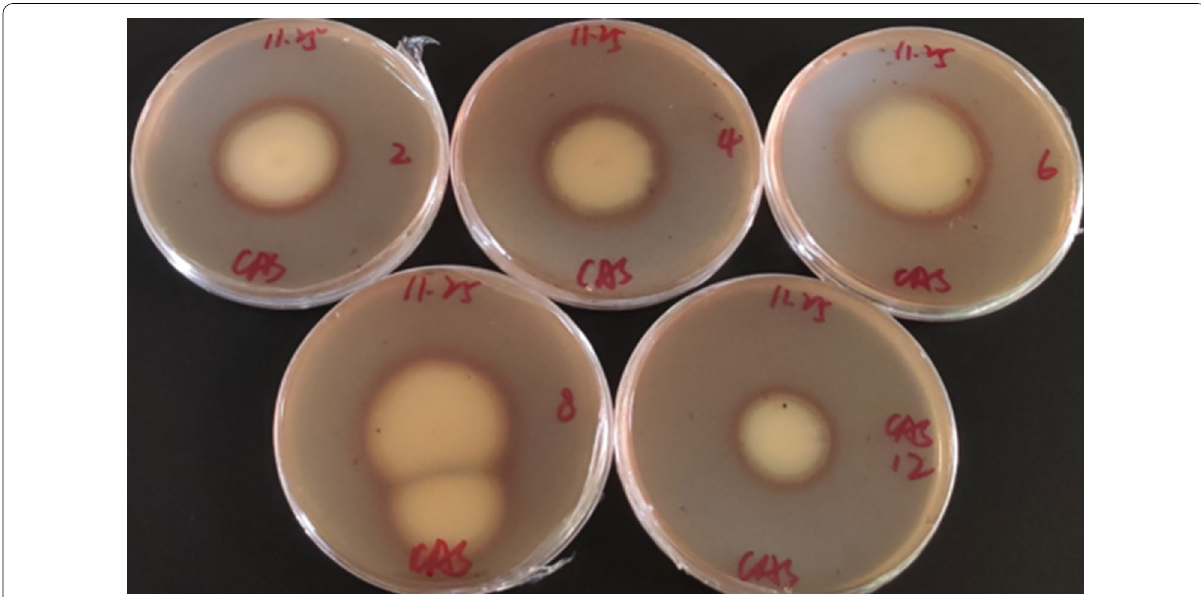
Fig.1 Primary screening of siderophore strains by CAS plate